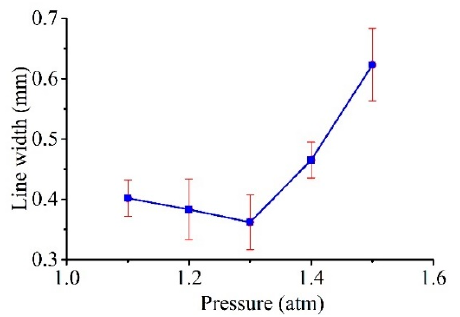
Figure 13. E ff ect of pressure P 1 on the line Figure 13. Effect of pressure P 1 on the line widths.